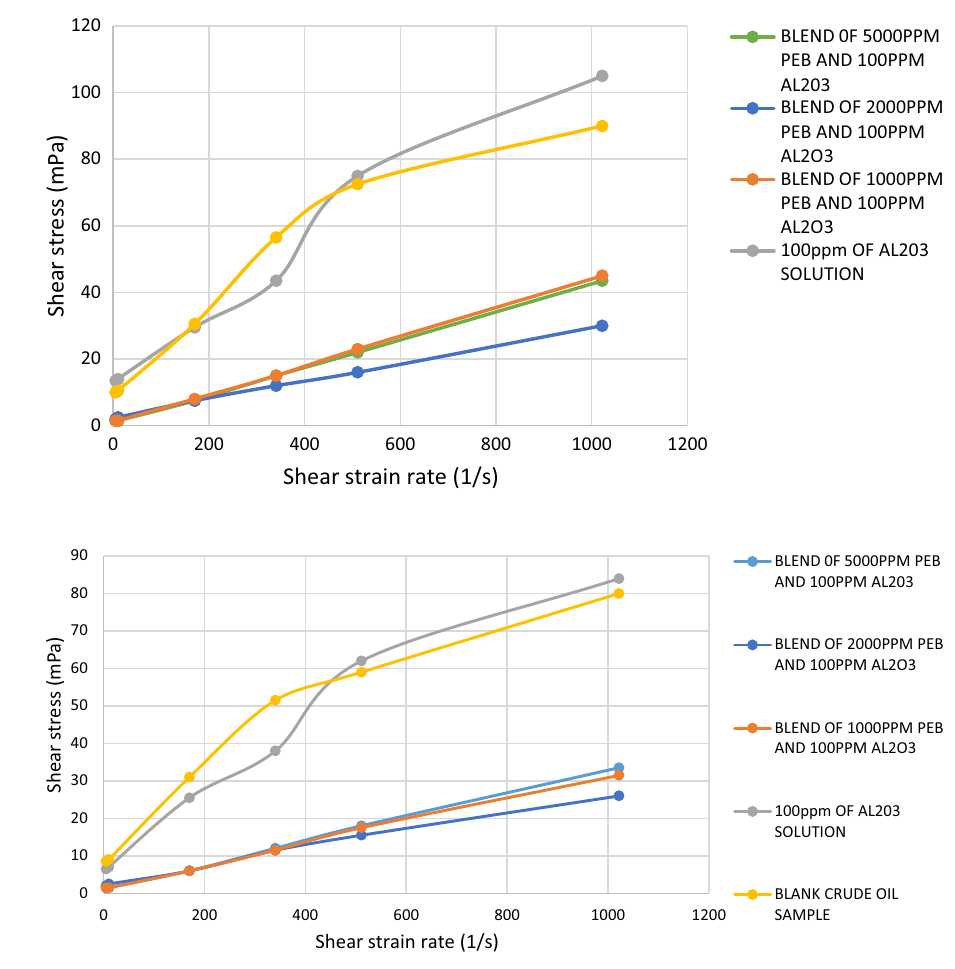
Fig. 4 Plot of shear stress against shear strain rate at 10 °C for the various inhibitors understudy